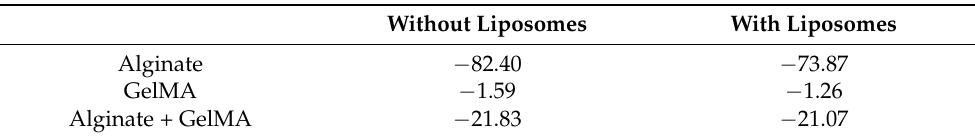
Table 1. Mean values of zeta potential (mV) of the pure polymers and their mixture before and after the addition of